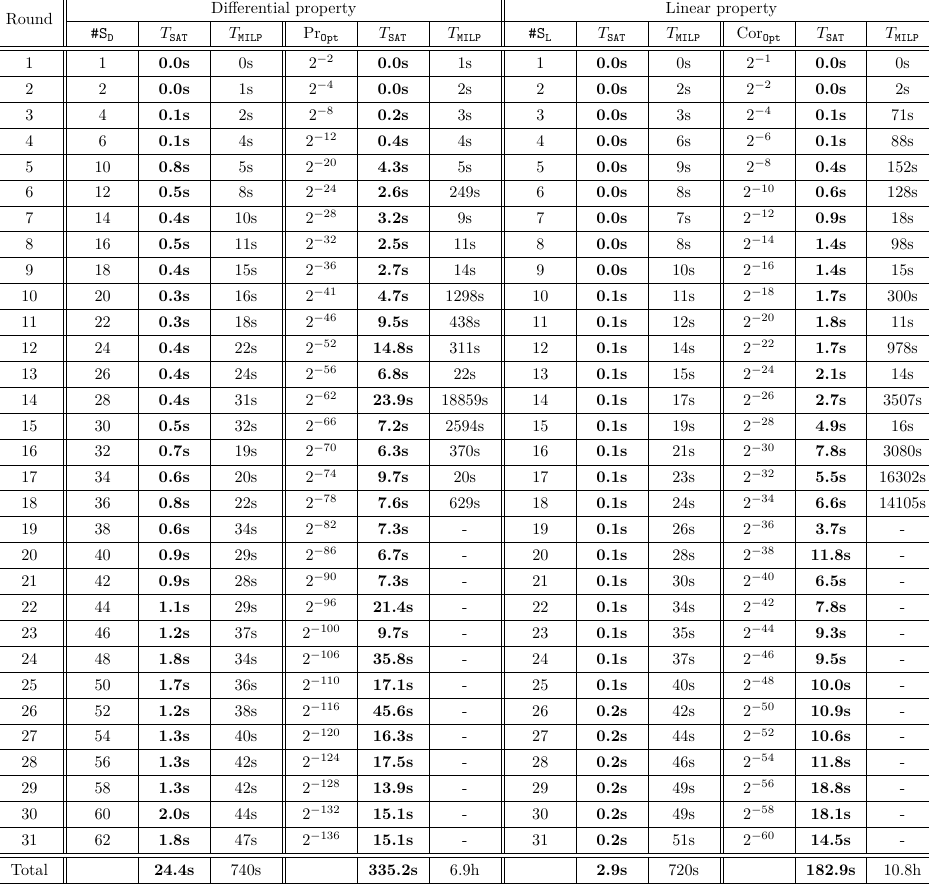
Table 3: Experimental results of PRESENT